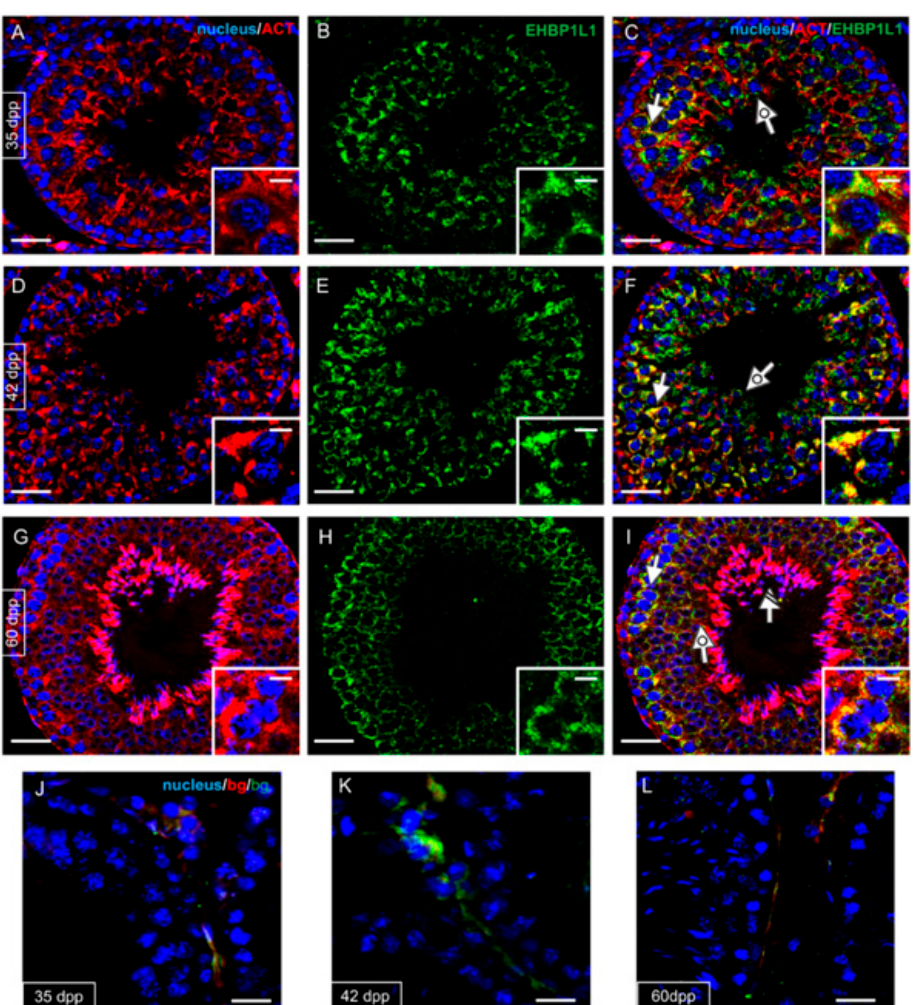
Figure 7. Co-localization of EHBP1L1 and ACTIN during the first wave of rat spermatogenesis (35–60 dpp). ( A , D , G , J ) DAPI-fluorescent nuclear staining (blue) and ACTIN staining (red). ( B , E , H , K ) EHBP1L1 fluorescence (green). ( C , F , I , L ) Merged fluorescent channels (blue/red/green). The intermediate yellow–orange tint indicates EHBP1L1 and ACTIN co-localization. ( A – C ) 35 dpp testis; ( D – F ) 42 dpp; ( G – I ) 60 dpp. ( J – L ) Negative controls for the same time points, obtained by omitting the primary antibodies . Scale bars represent 20 μ m, except for the insets, where they represent 10 μ m. Arrow: I SPC; dotted arrow: rSPT; striped arrow: eSPT.